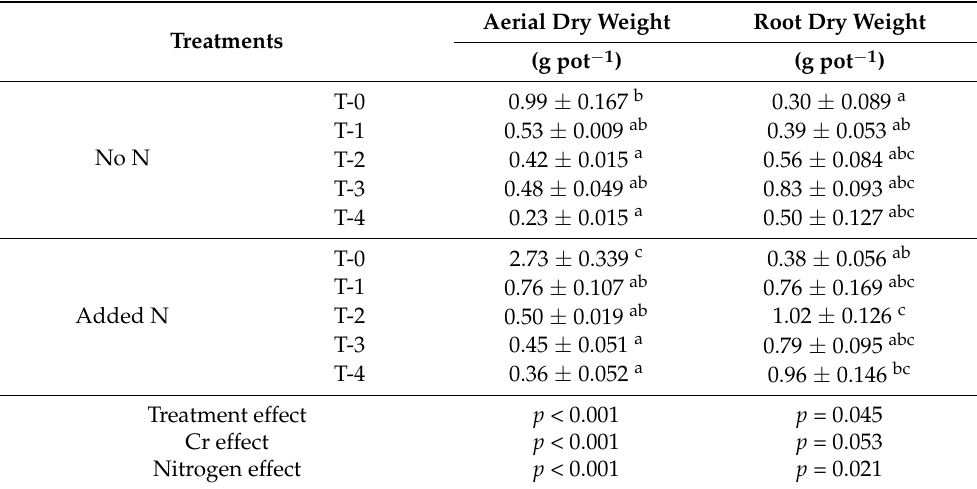
Table 2. Fresh and dry weight of aerial tissues, and dry weight of root tissues. Aerial Dry Weight Root Dry Weight Treatments (g pot − 1